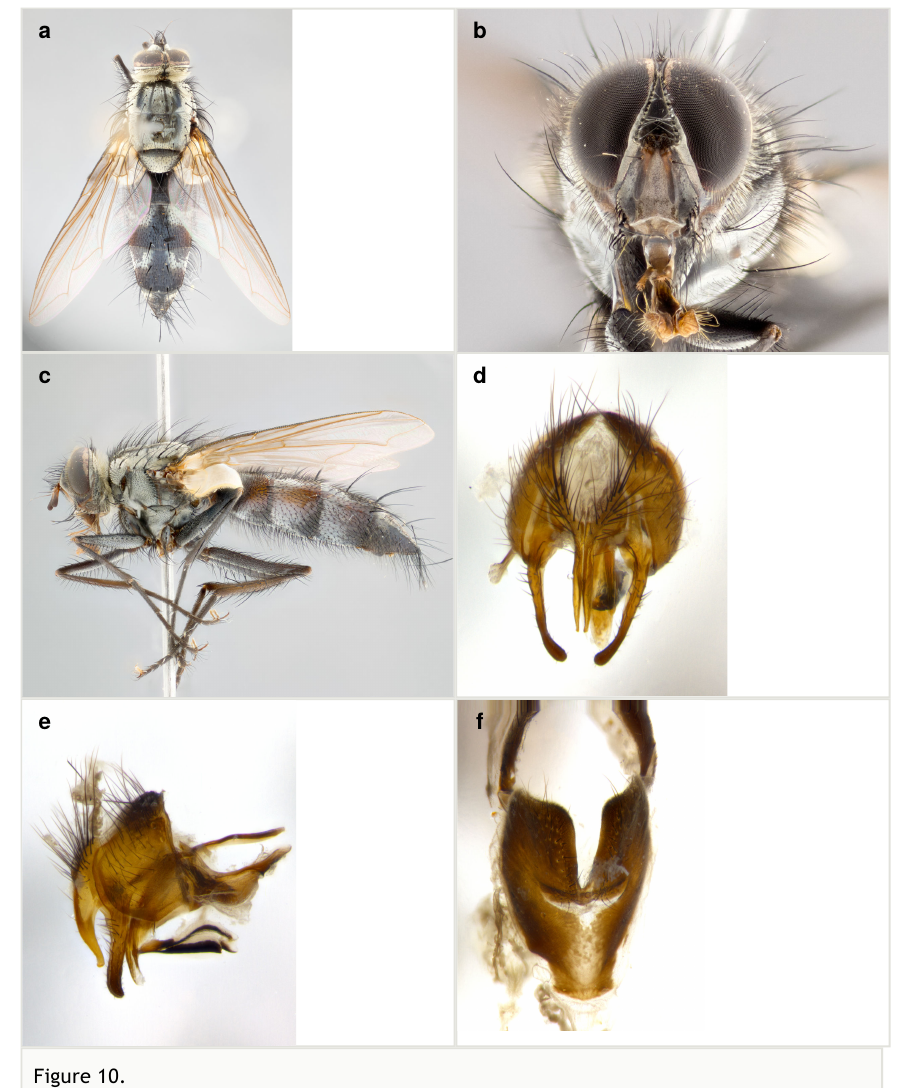
Uramya lativittata sp. nov. ; a-c : holotype male; voucher n. DHJPAR0011557; d-f : paratype male; voucher n.